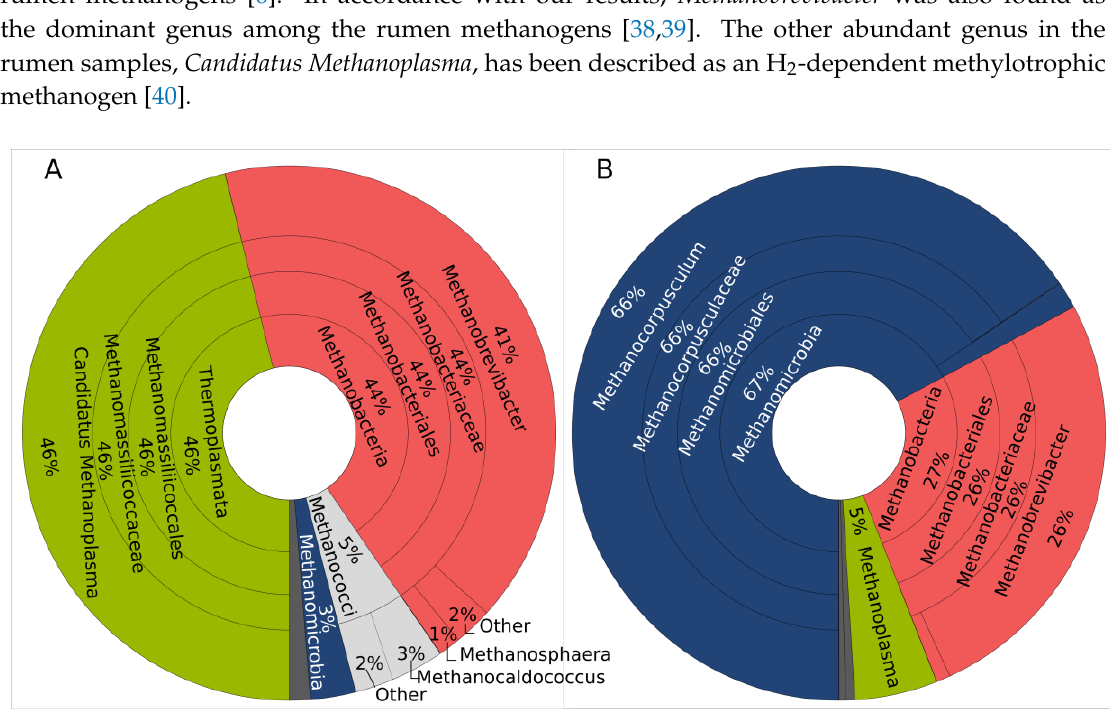
Figure 4. Krona charts illustrating the methanogenic community composition of ( A ) the rumen samples and ( B ) the manure samples on phylum, class, order, and family levels. Sequence data from three individuals were combined.